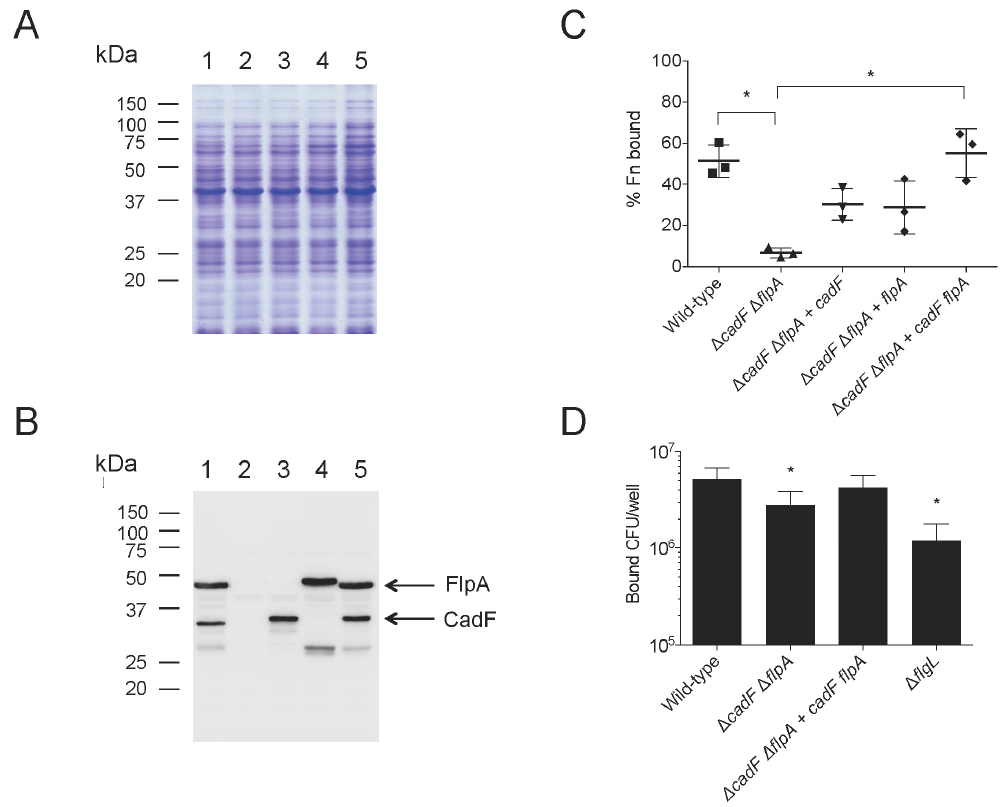
Figure 6. Maximal C. jejuni binding to soluble fibronectin (FN) and epithelial cells requires both CadF and FlpA. Bacterial whole-cell lysates were separated in SDS 12.5% polyacrylamide gels and either: ( A ) stained with Coomassie Brilliant Blue R-250 or ( B ) transferred to polyvinylidene fluoride membranes and probed with a mixture of the rabbit α -CadF serum and rabbit α -FlpA serum. The positive control consisted of a C. jejuni wild-type strain. Lanes: C. jejuni strains (1) 81-176 (wild-type); (2) ∆ cadF ∆ flpA ; (3) ∆ cadF ∆ flpA :: P cadF cadF ; (4) ∆ cadF ∆ flpA :: P flpA flp : and (5) ∆ cadF ∆ flpA :: P cadF cadF - P flpA flpA. ( C ) C. jejuni binding to soluble FN. C. jejuni were incubated with biotin-labeled FN for one hour,